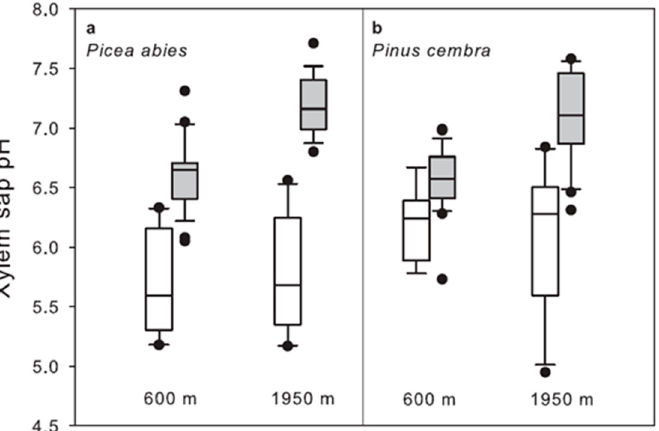
Figure 5. Seasonal change of pHx of ( a ) P. abies and ( b ) P. cembra twigs sampled at 600 m a.s.l. in comparison to samples from the alpine timberline at 1950 m. White boxes show values obtained during the growing period (n = 9), grey boxes show winter values (n = 25). The boxplots present the median and the 10th, 25th, 75th and 90th percentiles; outliers are shown as dots. For both species at both growing sites winter values were significantly different (Bonferroni at p < 0.05) from values obtained during the growing period. Winter alkalinisation was significantly higher ( t -test at p < 0.001) at 1950 m for both